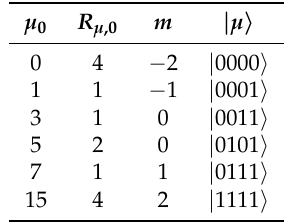
Table 2. Eigenvectors | µ 0 (cid:105) with N =